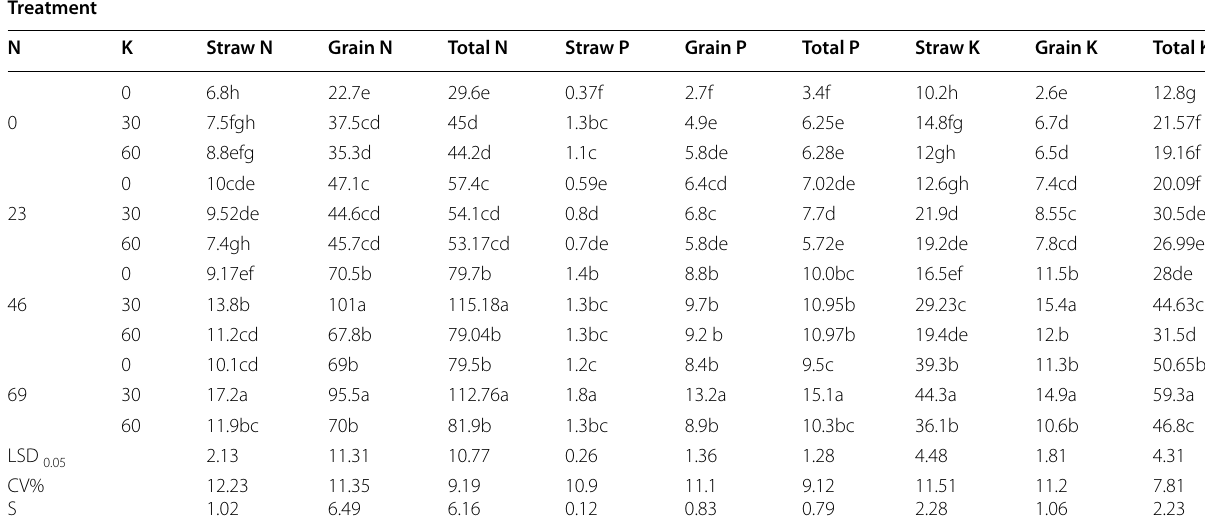
Means followed by the same letters within a column are not significantly different at 5% probability level * and **, significant at 5 and 1% level of significance, respectively, ns nonsignificant difference, CV (%) coefficient of variation in percent, S standard deviation